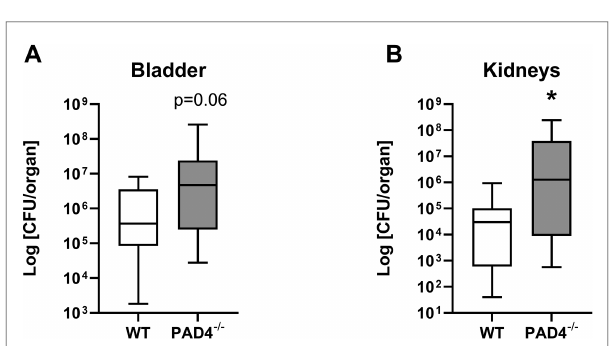
FIGURE 2 Concentration of antimicrobial peptides in urine of children with urinary tract infection (UTI) and in healthy controls (CTRL). ( A ) Myeloperoxidase (MPO), ( B ) Cathelicidin. Results are presented using box plots with median and interquartile range. Data were compared using Mann – Whitney U Test. **Denotes p <0.01, ***denotes p <0.001 in comparison to healthy children.